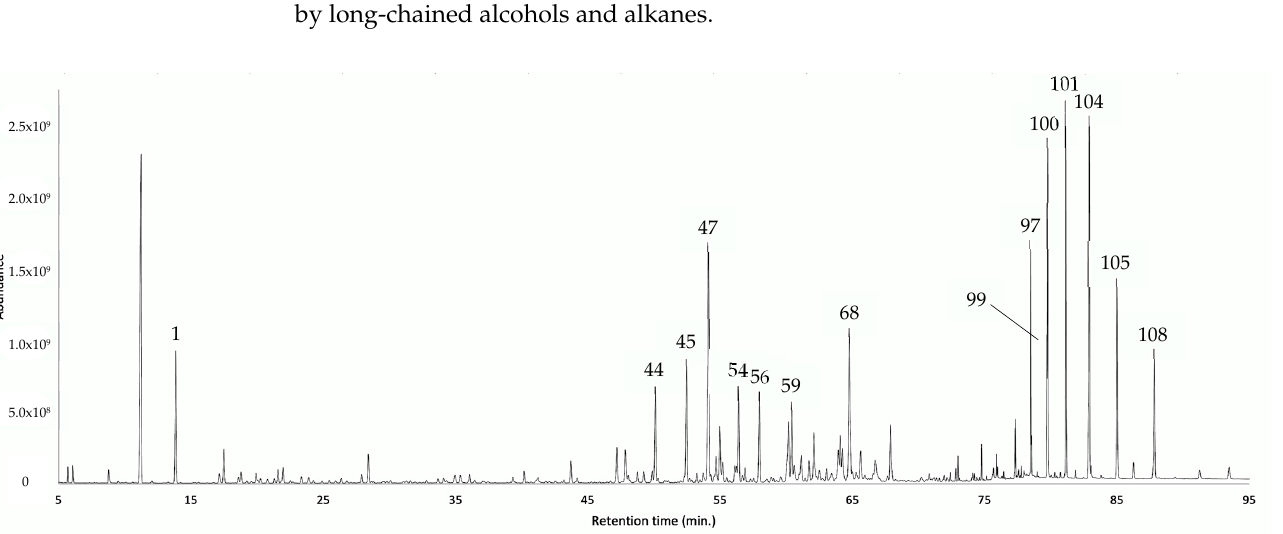
Figure 3. GC–MS chromatogram of the EO from the leaves of G. rugulosa in a polyethylene glycol- based column. The main components are represented with the respective peak number, according to Table 1. 2.2. Enantioselective Analysis of the EO For almost all the identified enantiomers, the enantioselective analysis was carried out through a 2,3-diacetyl-6- tert -butyldimethylsilyl- β -cyclodextrin capillary column, with the exception of α -copaene and germacrene D. For these compounds, a 2,3-diethyl-6- tert - butyldimethylsilyl- β -cyclodextrin column was used since their enantiomers are insepara- ble with the other chiral selector. As a result, eight enantiomeric pairs and two enantio- merically pure terpenes were detected. On the one hand, most of the chiral metabolites were present as scalemic mixtures, whereas α -terpineol was practically a racemate. On the other hand, (1 R ,5 R )-(+)- β -pinene and ( S )-(+)- β -phellandrene were enantiomerically pure. All the enantiomers were identified through the MS spectrum and by comparing their linear retention indices (LRI) with those of a mixture of enantiomerically pure stand- ards. The enantiomeric distribution and the enantiomeric excess ( e.e. ) of the detected en- antiomers are reported in Table 2.